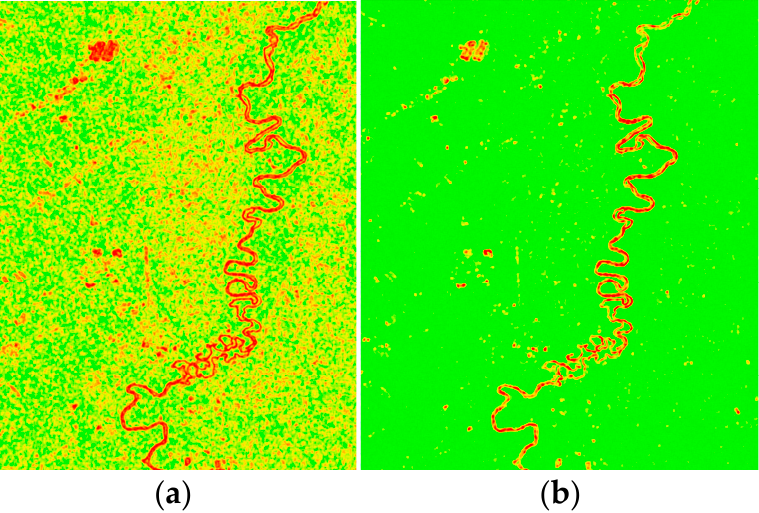
Figure 10. Entropy and contrast of the SAR image. ( a ) Entropy image. ( b ) Contrast image. (2) Influence of different data sources on superpixel decomposition for the water boundary